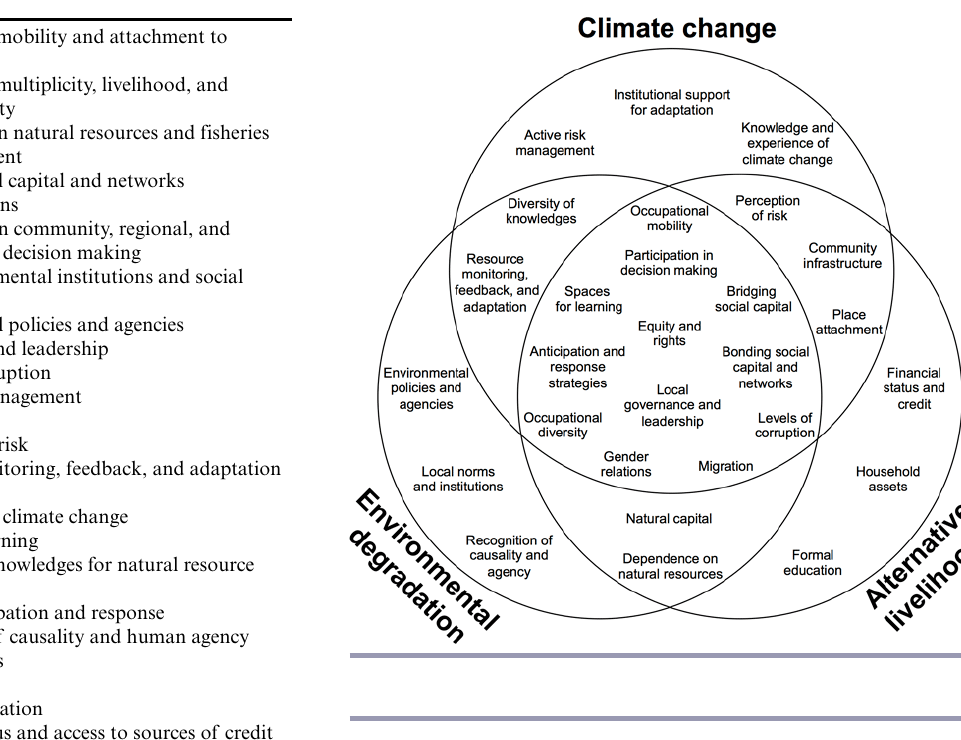
Fig. 2 . Map of research sites on the Andaman coast of